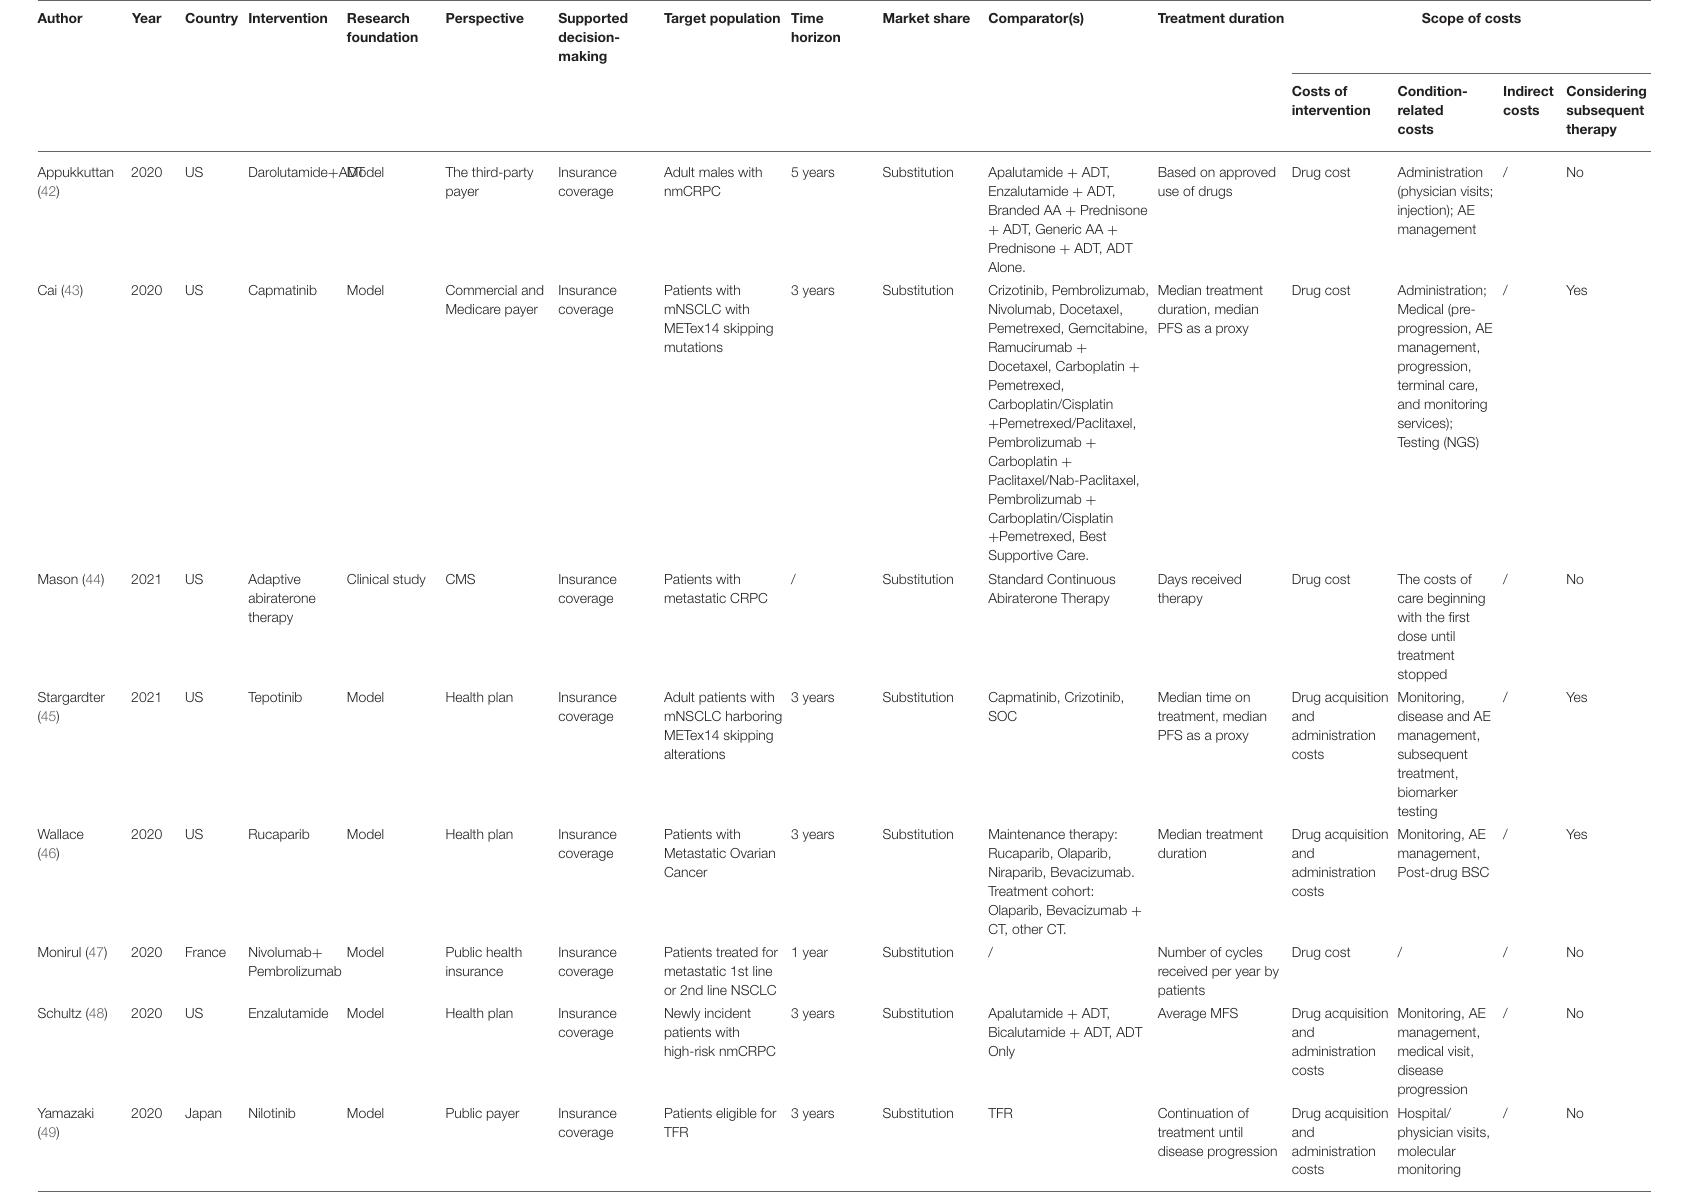
TABLE 3 | Characteristics of included